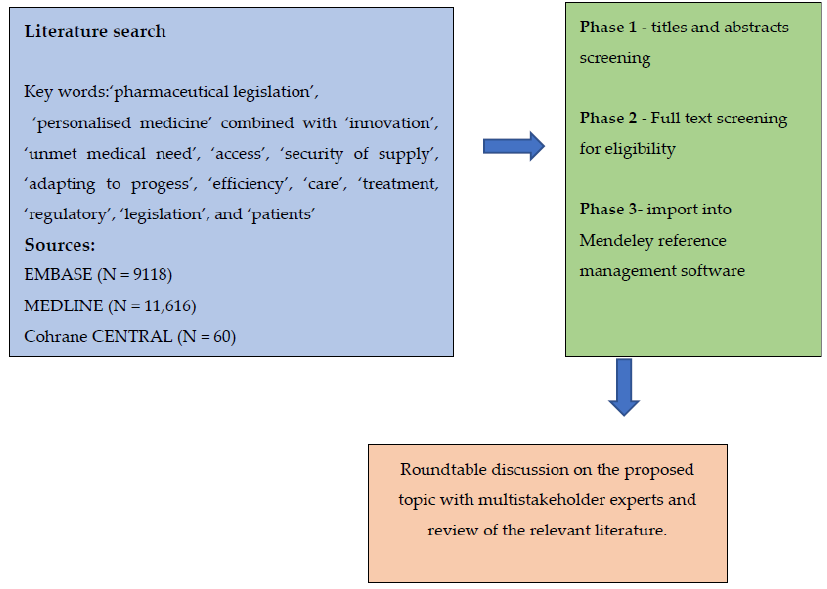
Figure 1. Applied research strategy; after literature search of relevant articles, an expert panel was organised to discuss the proposed topic and literature findings.